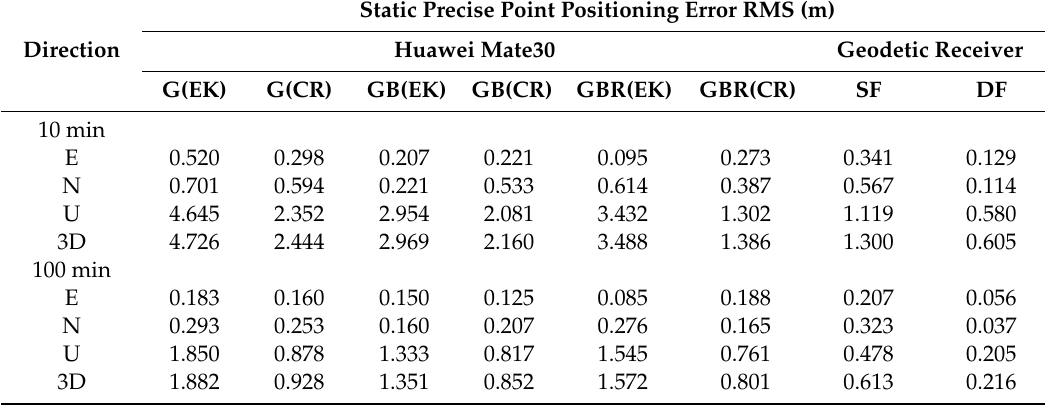
Table 2. RMS of GPS, GPS / BDS, and GPS / BDS / GLONASS static PPP errors of the Huawei Mate30 and geodetic receiver. 3D denotes